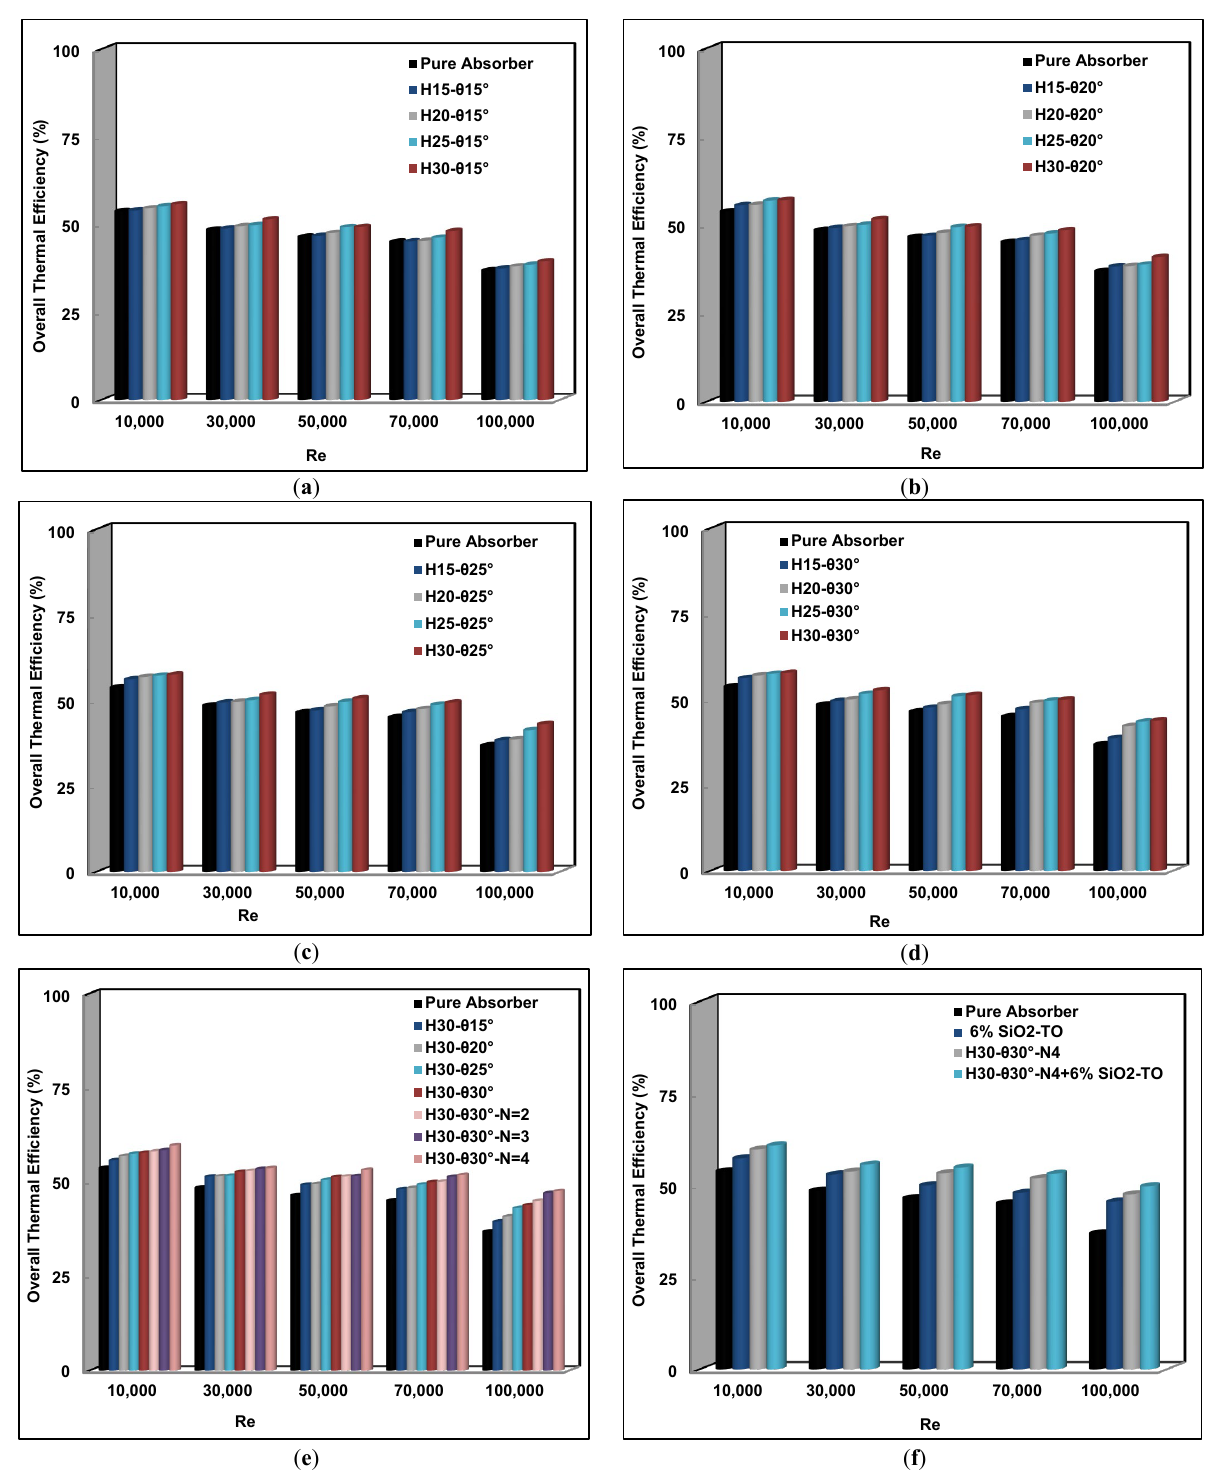
Figure 18. Overall thermal efficiency comparisons for all considered cases. ( a ) Pitch height variation with θ = 15°, ( b ) Pitch height variation with θ = 20°, ( c ) Pitch height variation with θ = 25°, ( d ) Pitch height variation with θ = 30°, ( e ) Pitch angle ( θ ) and number of inserts (N) variation with fixed pitch height, ( f ) Optimal configuration with and without nanofluids.